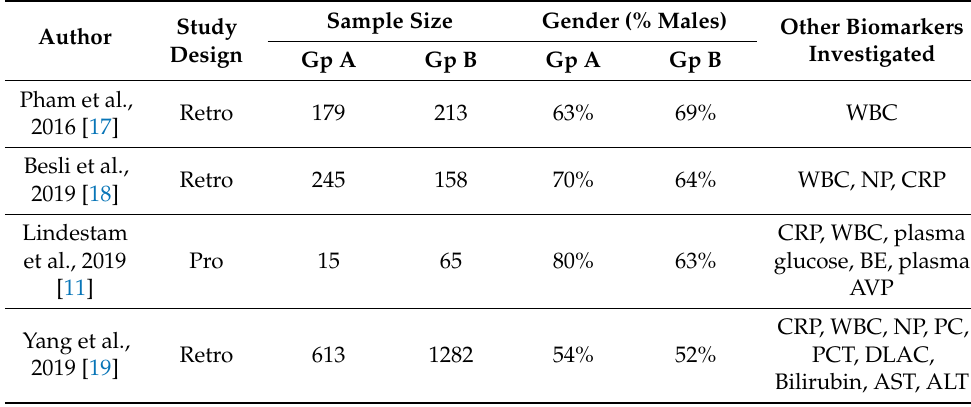
Figure 1. Selection of the relevant studies using the Preferred Reporting Items for Systematic Review and Meta-Analysis (PRISMA) flow diagram. Table 1. Baseline characteristics of the included